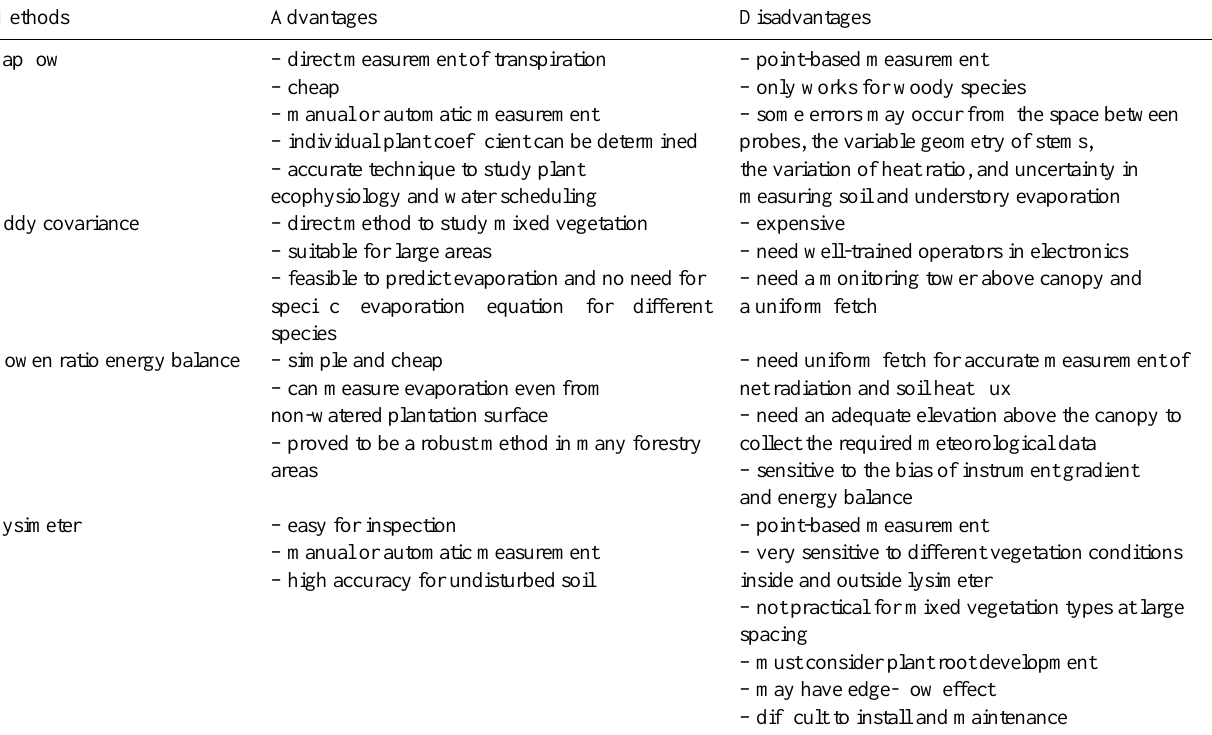
Table 1. Summary of hydrometric methods (adopted from Nouri et al.,